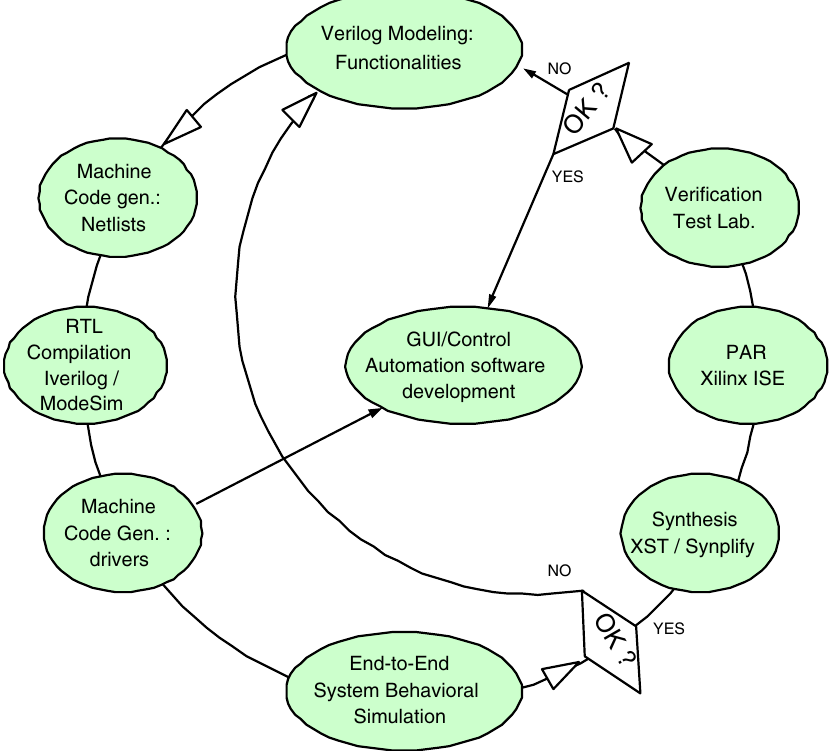
FIG. 2. (Color) Verilog HDL modeling and cosimulation process for the development of FCM digital hardware.